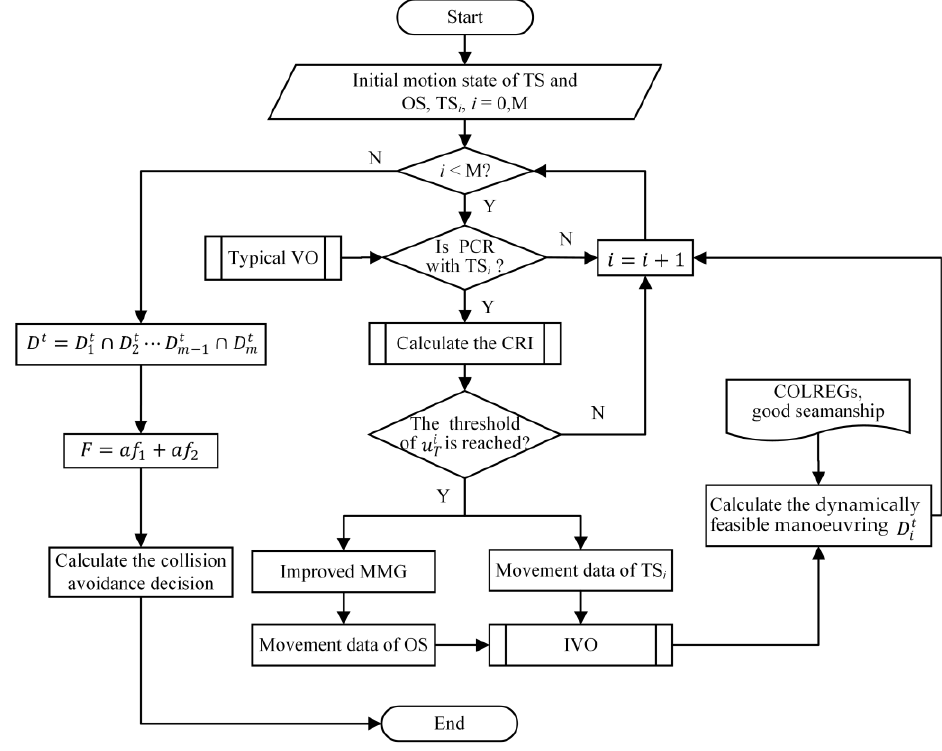
Figure 8. Decision-making of collision avoidance.